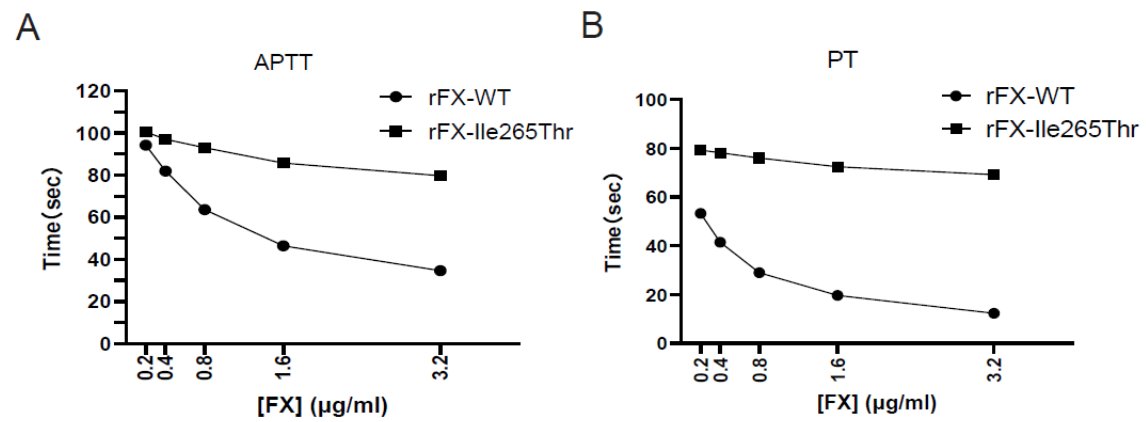
Figure 5. Plasma clotting activities of recombinant FX-WT and FX-Ile265Thr.The clotting activities of FX-WT( ● ) and FX-Ile265Thr ( █ ) were determined using FX-deficient plasma by both aPTT ( A ) and PT ( B ) assays as a function of different concentrations(from 0.2 to 3.2 of the zymogens at 37°C as described in Materials and methods. Data are derived from three independent measurements (SD).